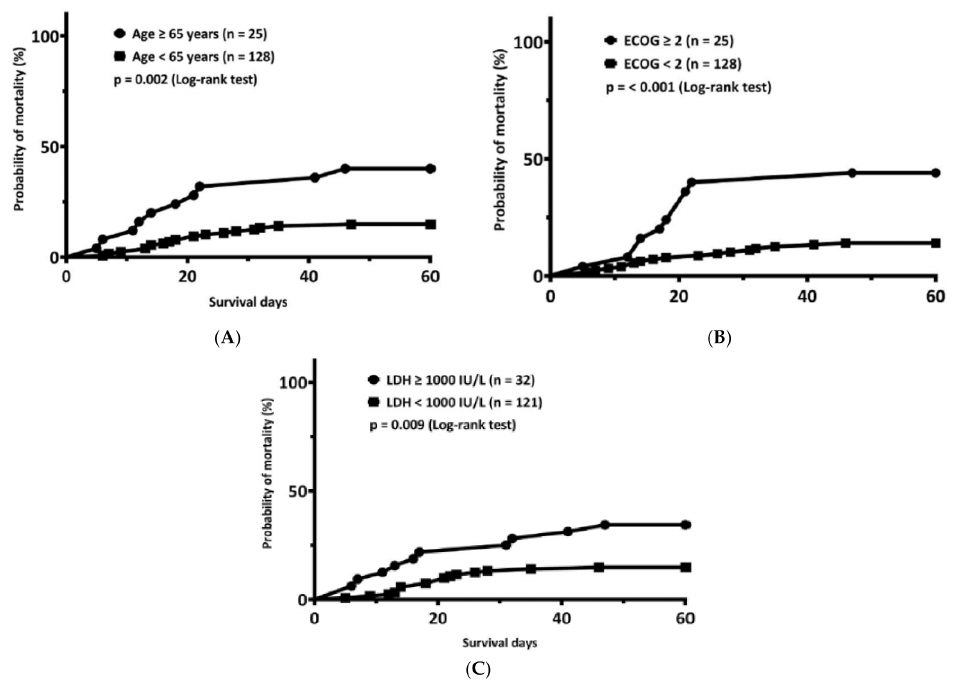
Figure 1. The cumulative incidence of early mortality by risk factors. ( A ) The cumulative early mortality rate of patients ≥ 65 and <65 years of age was 40.0% and 14.8%, respectively ( p = 0.002). ( B ) It was 44.0% and 14.1% for patients with Eastern Cooperative Oncology Group (ECOG) performance status (PS) ≥ 2 and <2 ( p < 0.001), respectively. ( C ) The cumulative early mortality rate among patients with a lactate dehydrogenase (LDH) ≥ 1000 and <1000 IU/L was 34.4% and 14.9%, respectively ( p =